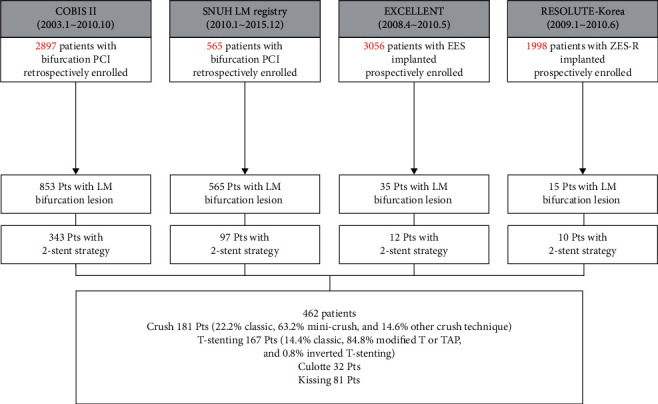
Study population from 4 multicenter registries. EES, everolimus-eluting stent(s); LM, left main; PCI, percutaneous coronary intervention; TAP, T and protrusion; ZES-R, zotarolimus-eluting resolute stent.